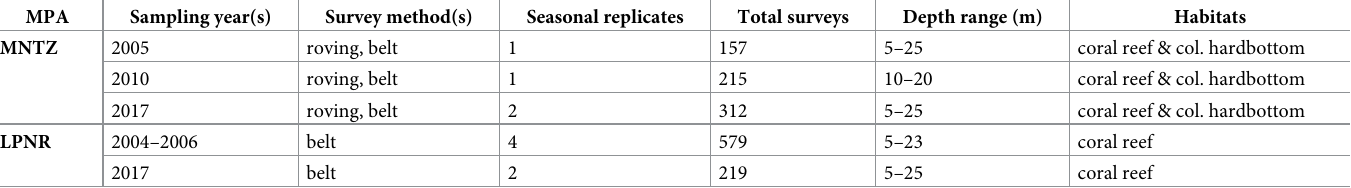
Table 1. Summary of sampling effort.